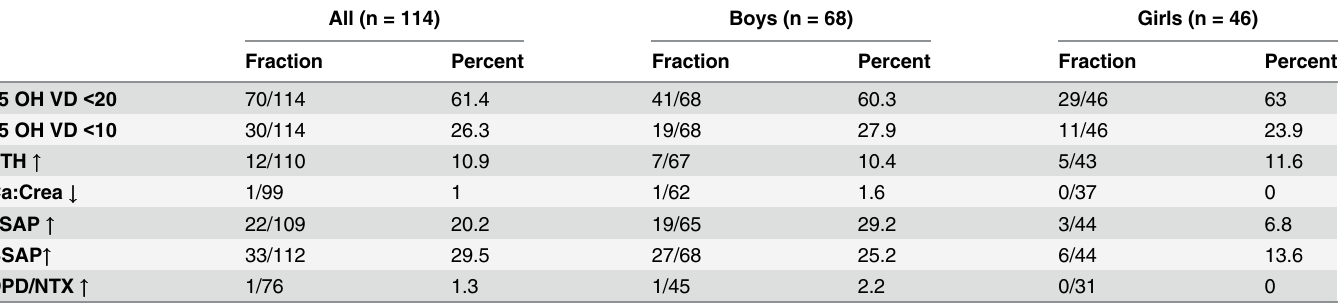
Fraction and percentage are presented for the following altered biochemical characteristics of bone metabolism: vitamin D de fi ciency (25-OH VD < 20 ng/ mL, including patients with severe vitamin D de fi ciency), severe vitamin D de fi ciency (25-OH VD < 10 ng/mL), elevated parathyroid hormone (PTH), decreased calcium excretion in the urine (Ca:Crea < 0.03 mg/mg), elevated total serum alkaline phosphatase (TSAP), elevated bone-speci fi c